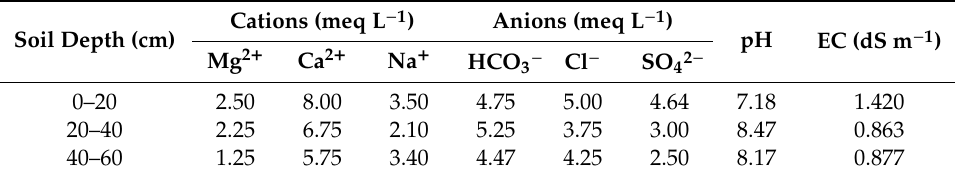
Table 2. Soil chemical parameters in three sampling